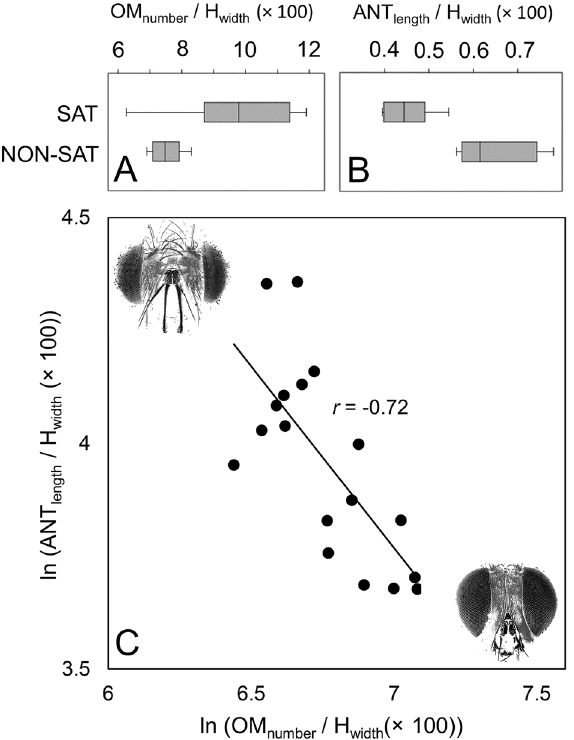
Figure 6. Relationship of host-foraging strategy (SAT and NON-SAT) with ommatidia number (OM number ) ( A ) and antennal length (ANT length ) ( B ), relative to H width . ( C ) Relationship between ln-transformed values of OM number and ANT length , relative to H width, across the studied species. Pearson correlation’s r is shown. Modified (to highlight eyes and antennae) pictures represent, in the upper left and in the lower right, respectively, the typical morphology of a NON-SAT species (smaller eyes and larger antennae, M. argyrocephala ) and the typical morphology of a SAT species (larger eyes and smaller antennae, P. melanura